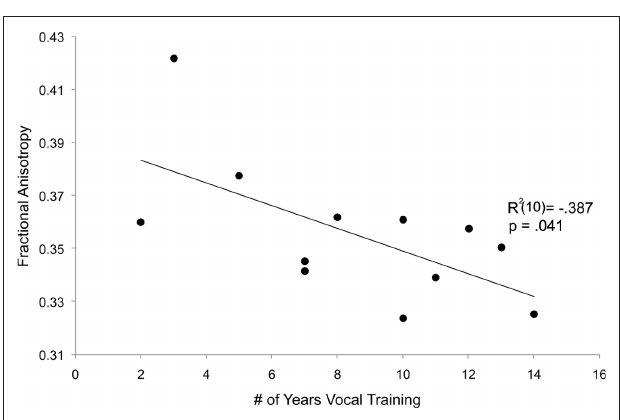
Figure 7 | Sagittal view of left dorsal AF across all subjects in green, with region showing significant between-group FA differences indicated by the box.